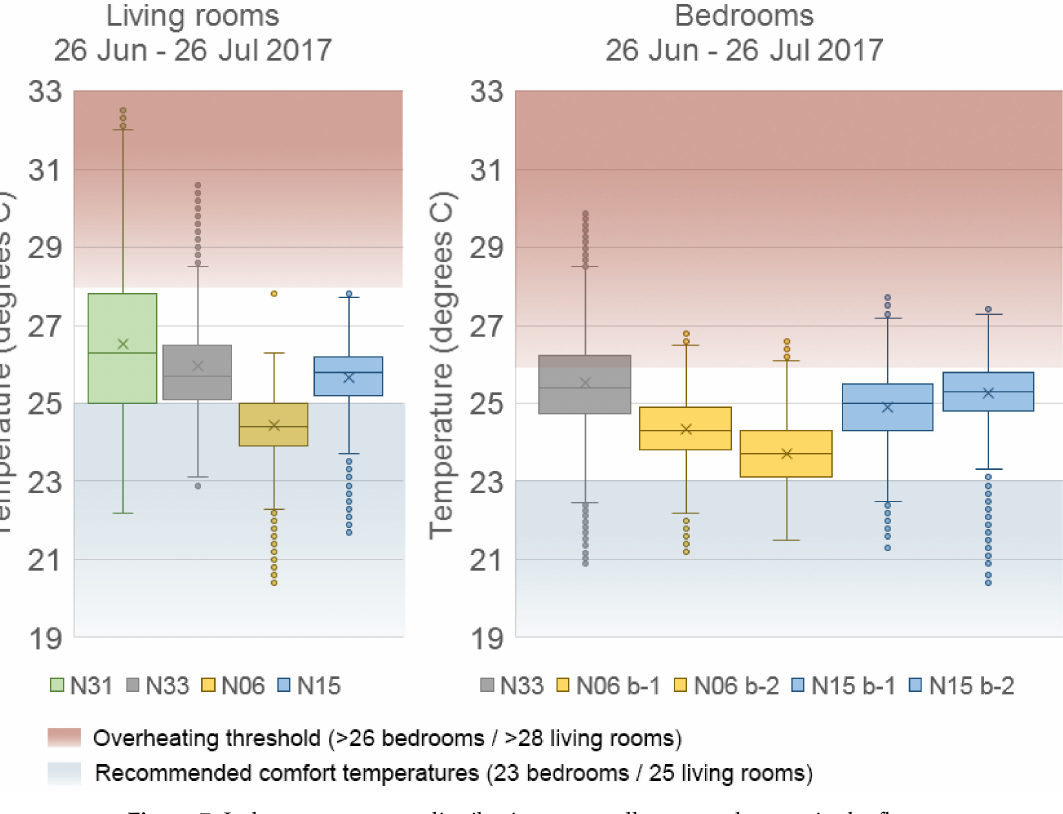
Figure 7. Indoor temperature distribution across all measured rooms in the flats.